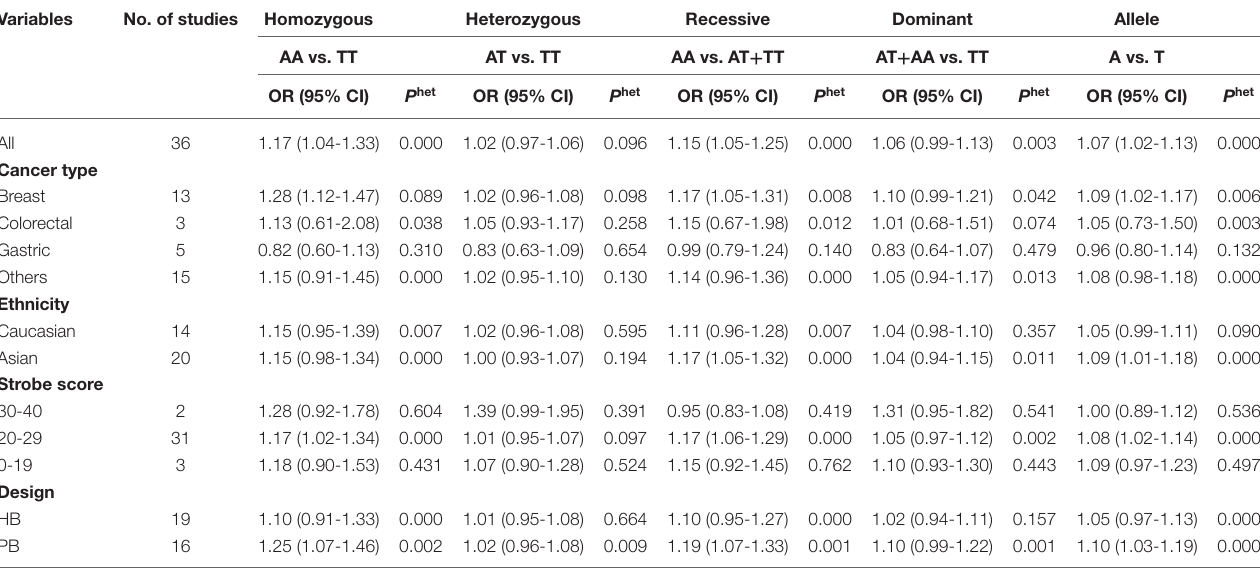
TABLE 2 | The association between the AURKA rs2273535 T > A polymorphism and cancer risk in the meta-analysis.